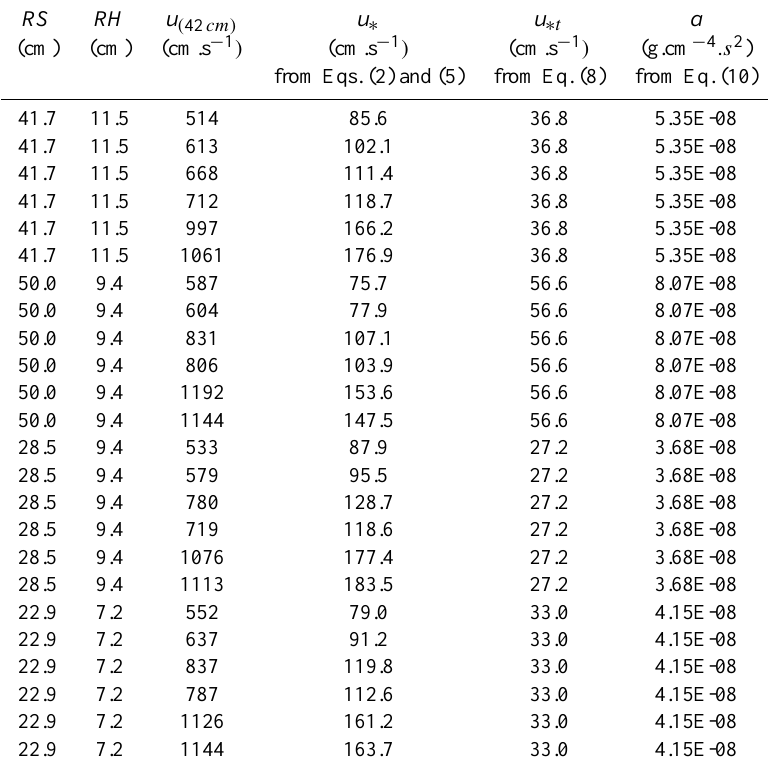
Table 5. Geometric characteristics of the ridges for the additional data set and computed values for u ∗ ,u ∗ t and a . RS RH